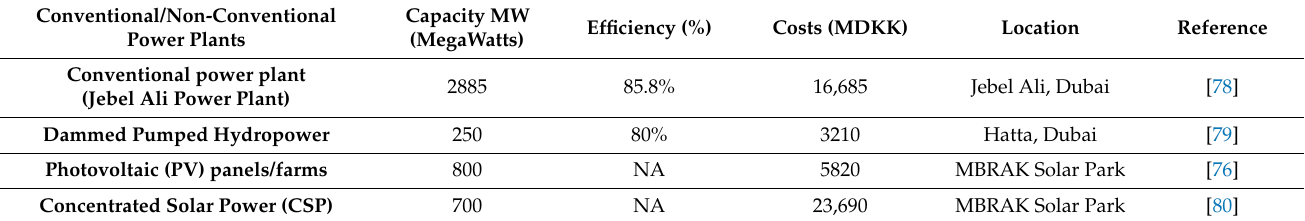
Figure 10. Projection of the monthly average electricity demand and production in the UAE in 2030. Table 13. Input data for the power